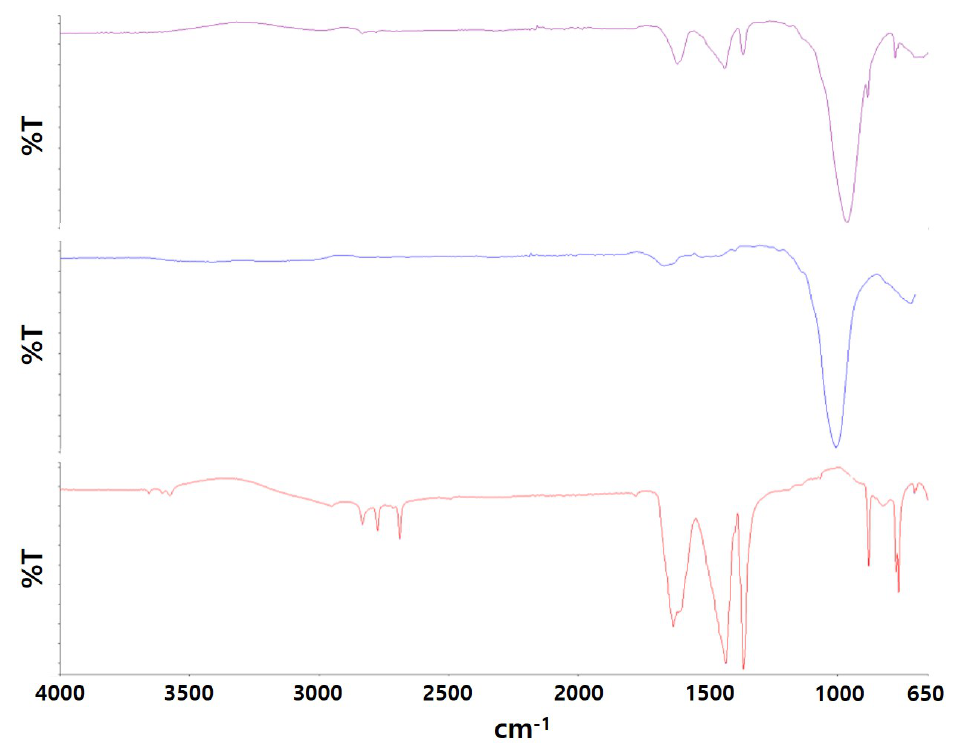
Figure 1. FT − IR spectrum of NaOMe/zeolite catalyst in comparison to NaOMe and zeolite.